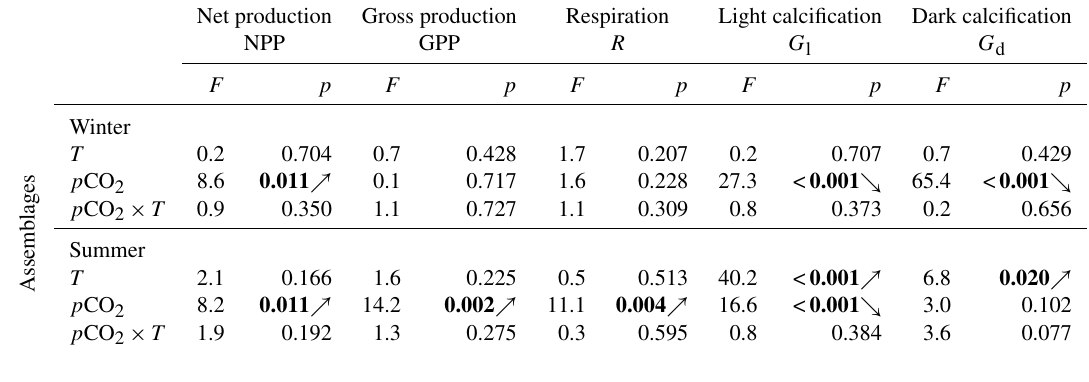
Table 8. Results the analysis of variance testing the effects of temperature ( T ) and p CO 2 on net and gross primary production, respiration, and light and dark calcification rates, measured on assemblages ( n = 5). Significant p values are presented in bold ( α = 0.05). Degrees of freedom =